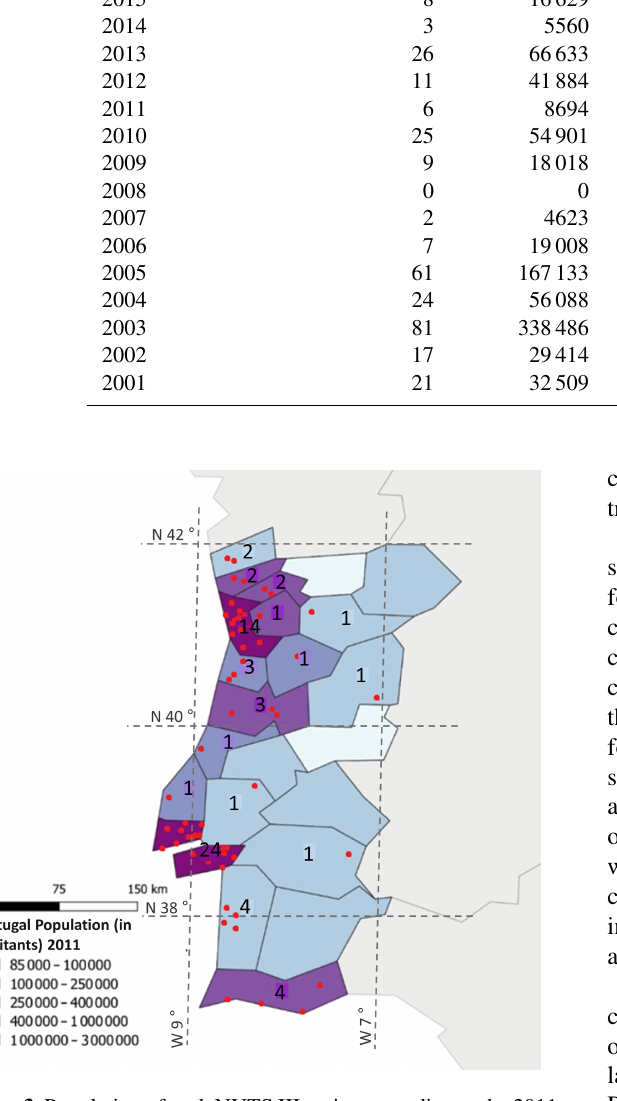
Figure 3. Population of each NUTS III region according to the 2011 Census (https://www.ine.pt, last access: 16 October 2019) and re- spective number of monitoring stations for PM 10 . Red dots indicate the location of the air quality monitoring stations used in this